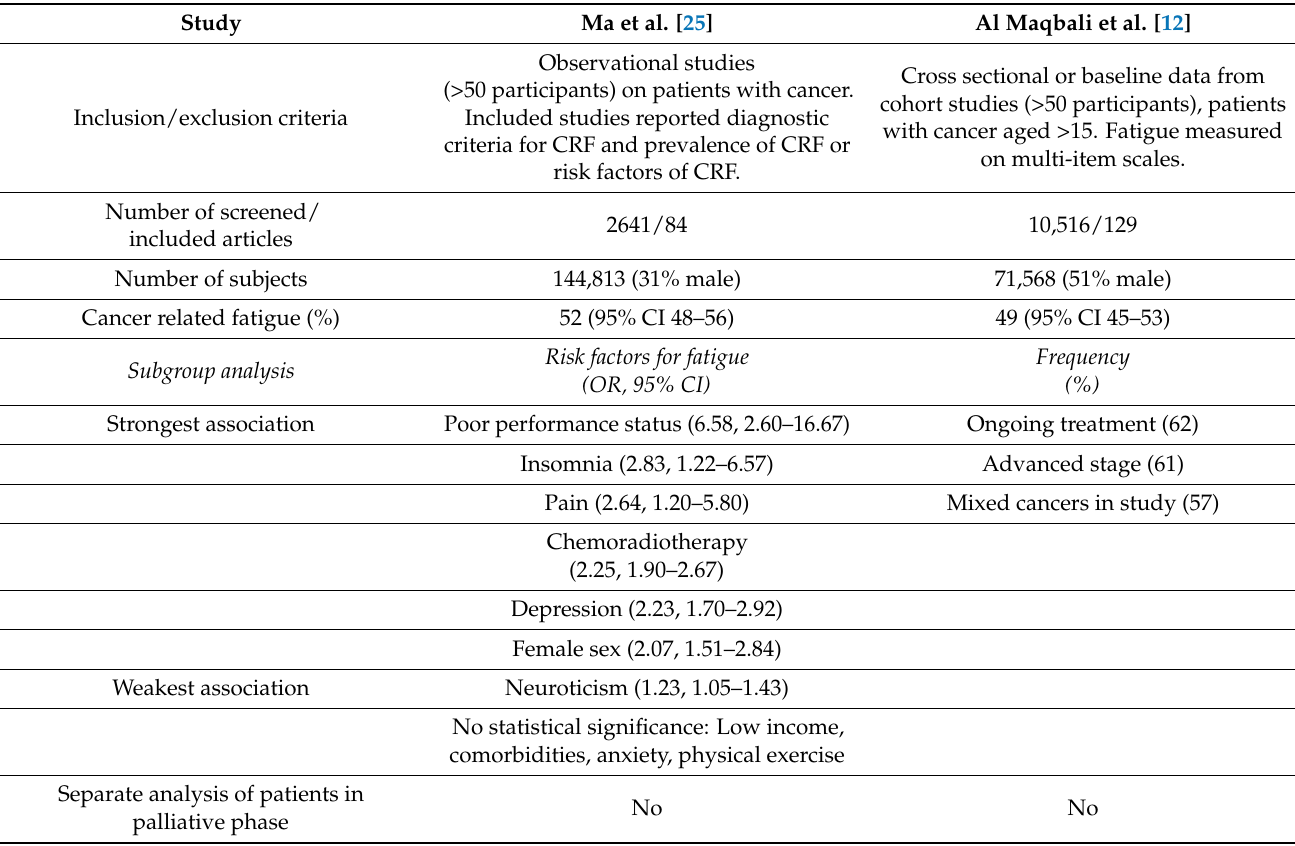
Table 2. Comparison of two meta-analyses on the prevalence of cancer related fatigue. Study Ma et al. [25] Al Maqbali et al.